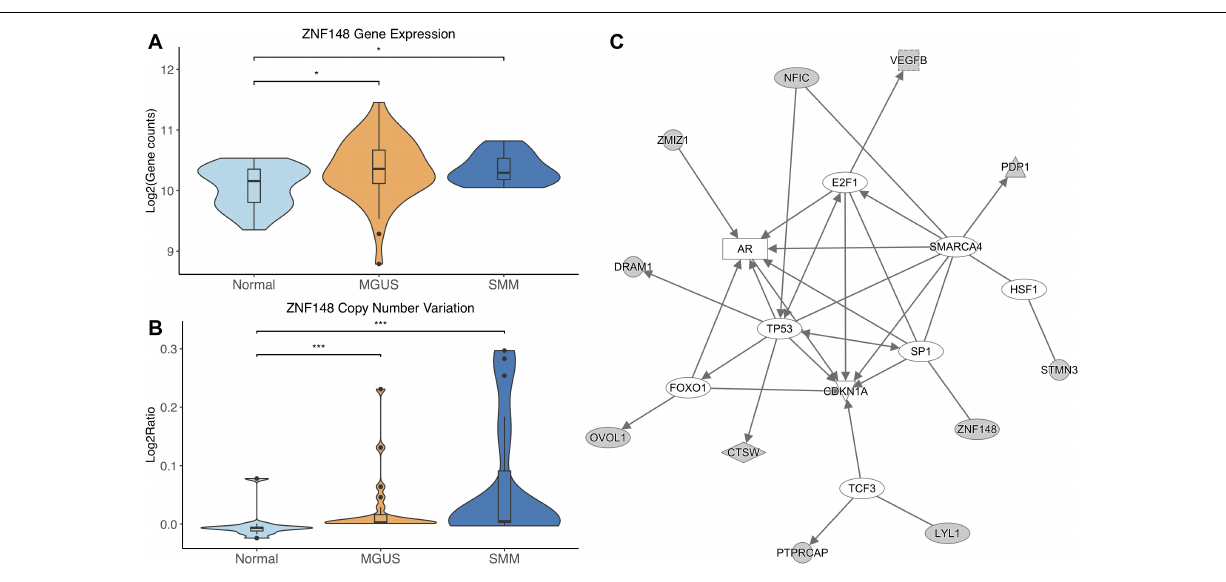
FIGURE 4 | (A) ZNF148 expression across sample groups. Mann–Whitney tests showed significant differential expression between Normal and MGUS ( p = 1.75E-02) and between Normal and SMM ( p = 4.05E-02). (B) Observations of ZNF148 copy number. Mann–Whitney tests showed significant copy number variation between Normal and MGUS ( p = 4.76E-04) and between Normal and SMM ( p = 3.11E-04). (C) A predicted interaction network of ZNF148 and its downstream targets. The gray nodes indicate genes from our module and the white nodes are gene interactions defined in IPA. Solid lines between nodes indicate a direct interaction supported by the Ingenuity Knowledge Base. Significance levels: ∗ p ≤ 0.05; ∗∗ p ≤ 0.01; ∗∗∗ p ≤